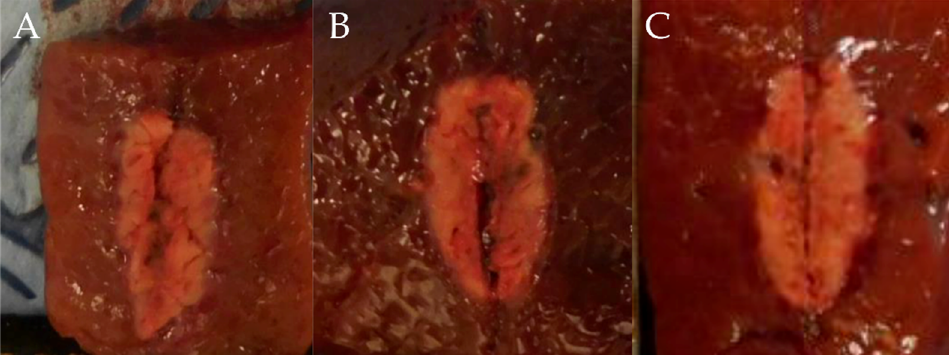
Figure 3. Relationships of ablation effect on probe tip length and RFA power. The vertical axis rep- resents the width (cm) and depth (cm) of ablation zones.